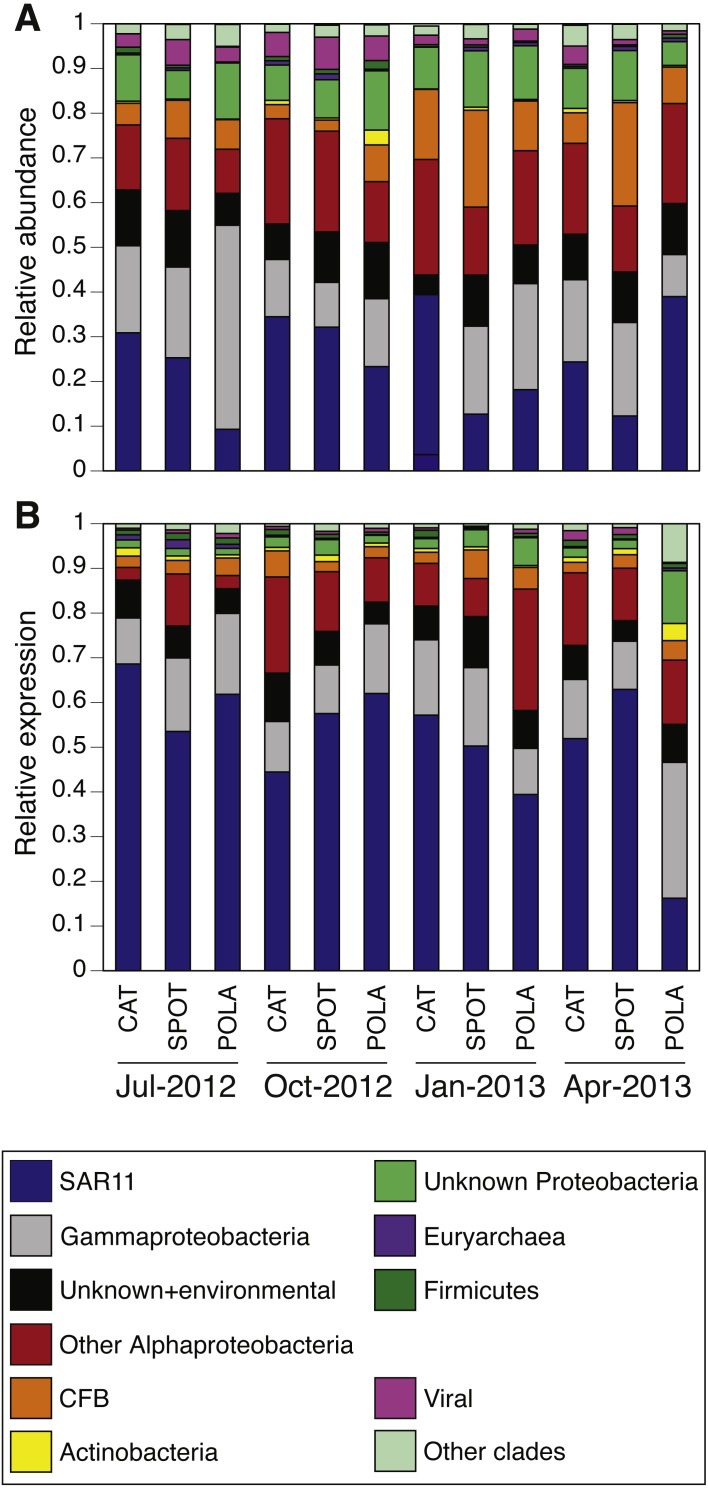
Relative abundance of various proteorhodopsins clusters (PR) out of all PR-assigned reads per sample.Relative abundance was calculated out of all rhodopsin-assigned reads per sample in (A) metagenomes (average PR reads per sample 6,485, standard deviation 3,927) and (B) metatranscriptomes (average PR reads per sample 43,005, standard deviation 22,367). The evenness of rhodopsin gene abundance was consistently high (see also sup. Fig. S7), whereas expression was dominated by SAR11 (dark blue), Gammaproteobacteria (grey), other Alphaproteobacteria (red) and unknown environmental clades 1 and 8 (black). The “Other clades” category includes rhodopsins of the MicRhoDE clusters Planctomycetes, bacteriorhodopsin, halorhodopsin, the “other rhodopsins” clade, NQ, xenorhodopsin, sensory rhodopsins, Betaproteobacteria, Deltaproteobacteria, Octadecabacter and Verrucomicrobia (Boeuf et al., 2015).